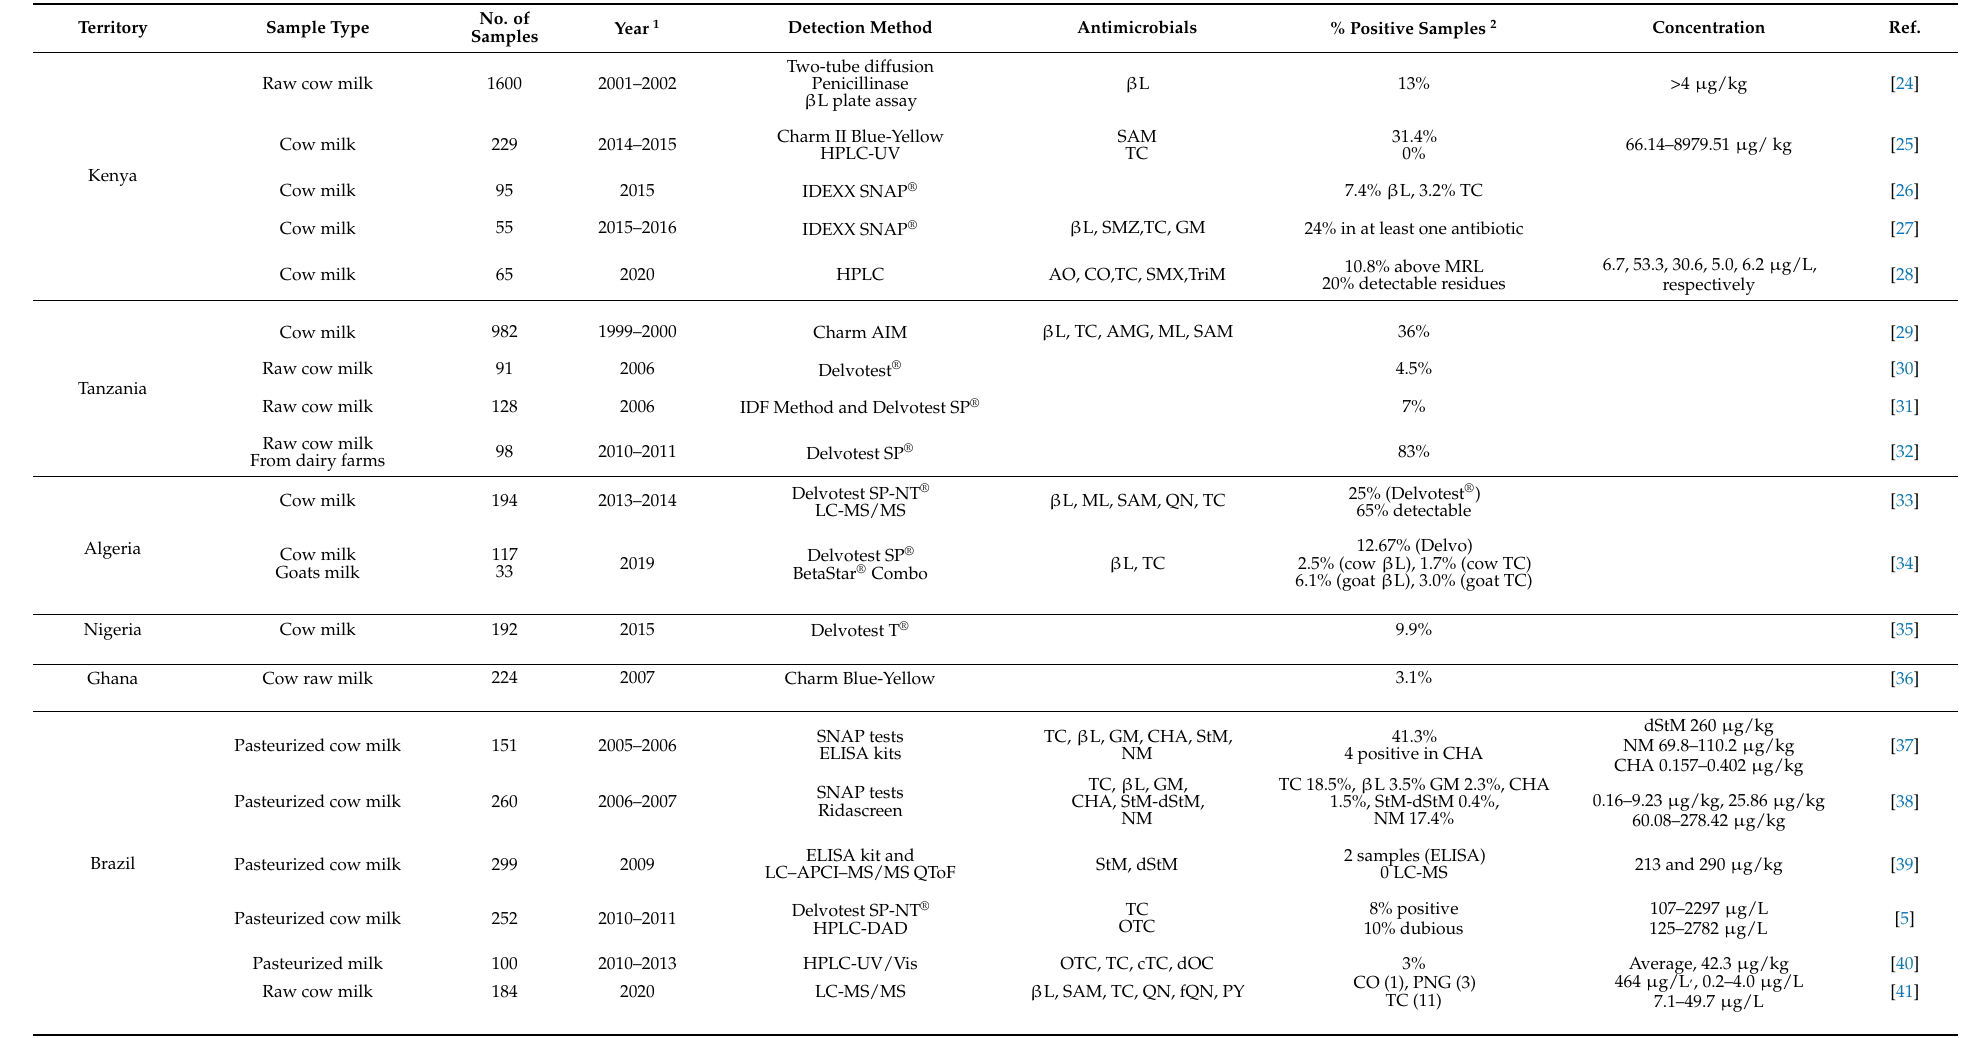
Table 2. Published research works on the detection of antibiotic residues in